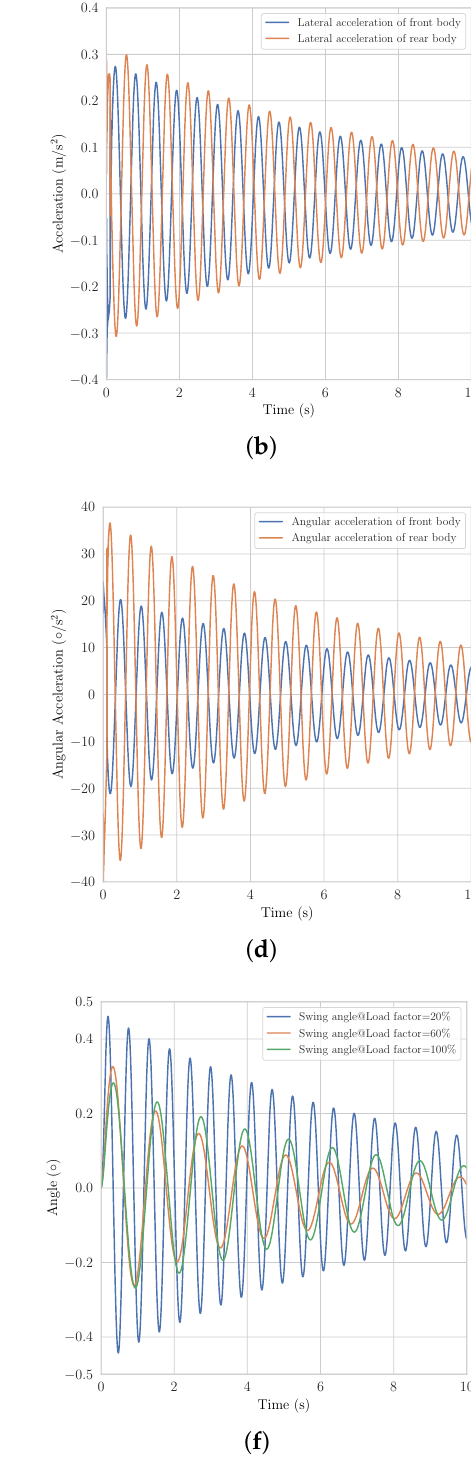
Figure 4. Simulation results: ( a ) lateral velocity, ( b ) lateral acceleration, ( c ) angular velocity, ( d ) angu- lar acceleration, ( e ) variation of the swing angle regarding the vehicle velocity, and ( f ) variation of the swing angle regarding the load